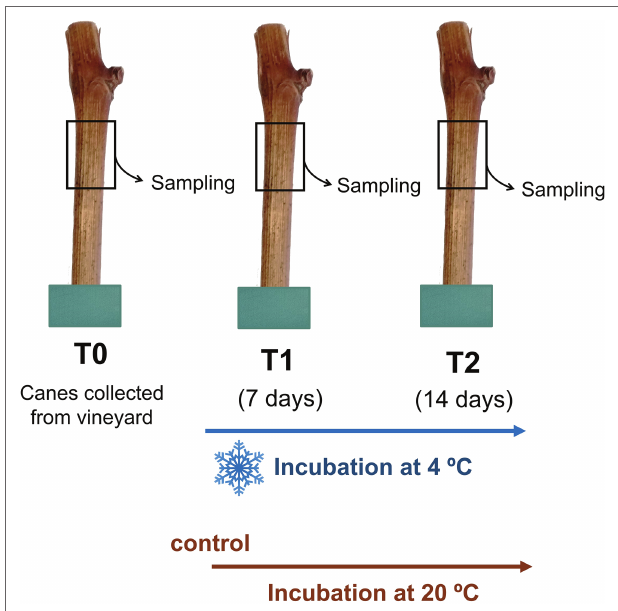
FIGURE 1 | Experimental design. Vitis vinifera woody canes (cv. Vinhão) cut into single bud segments were incubated in at 4 ° C for 7 and 14 days (T1 and T2, respectively). Samples at the beginning of the experiment were also collected (T0). Control canes were also incubated at 20 ° C for 7 and 14